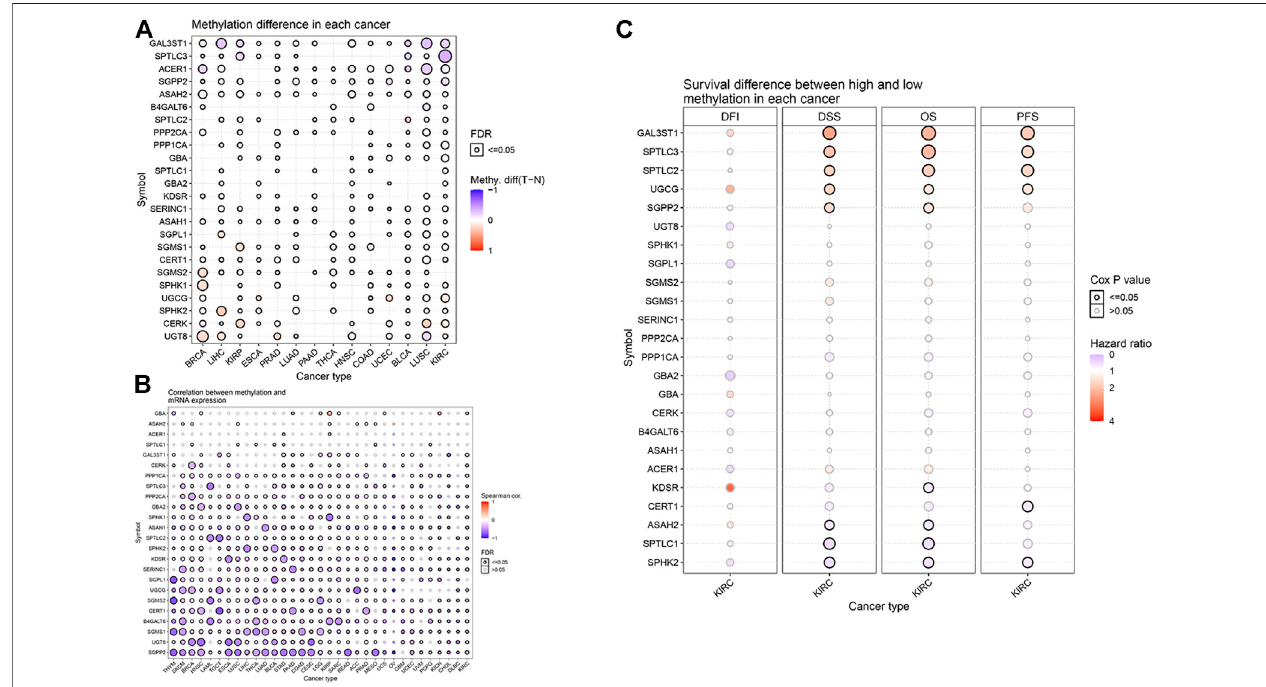
FIGURE 4 | Effect of sphingolipid methylation. The solid spheres demonstrate that the result is statistically signi fi cant ( p < 0.05), the size of the sphere shows the degreeofcorrelation,andthelargerthesphere,thehigherthedegreeofcorrelation. (A) Widespreadmethylationofsphingolipid-relatedgenesin14cancers.Inthecolor bar on the right side, red represents an increase in methylation level, and blue represents a decrease level. (B) The relationship between sphingolipid gene methylation and cancer mRNA expression. In the color bar on the right side, red represents an increased mRNA expression, blue represents a decreased mRNA expression. (C) SphingolipidgenemethylationandKIRCsurvivalevaluationindex.ThecolorbarontherightsiderepresentstheHR.RedrepresentsahigherHR(themaximumvalue is 4), which means a longer life span, and gray represents a lower risk ratio (the minimum value is 0), which means insigni fi cant change. The methylation of GAL3ST1, SPTLC3, SPTLC2, and UGCG can lead to prolongation of OS, DSS, and PFS in patients with KIRC, and SGPP2 methylation can lead to prolonged OS and DSS. The change in DFI is not statistically signi fi cant.